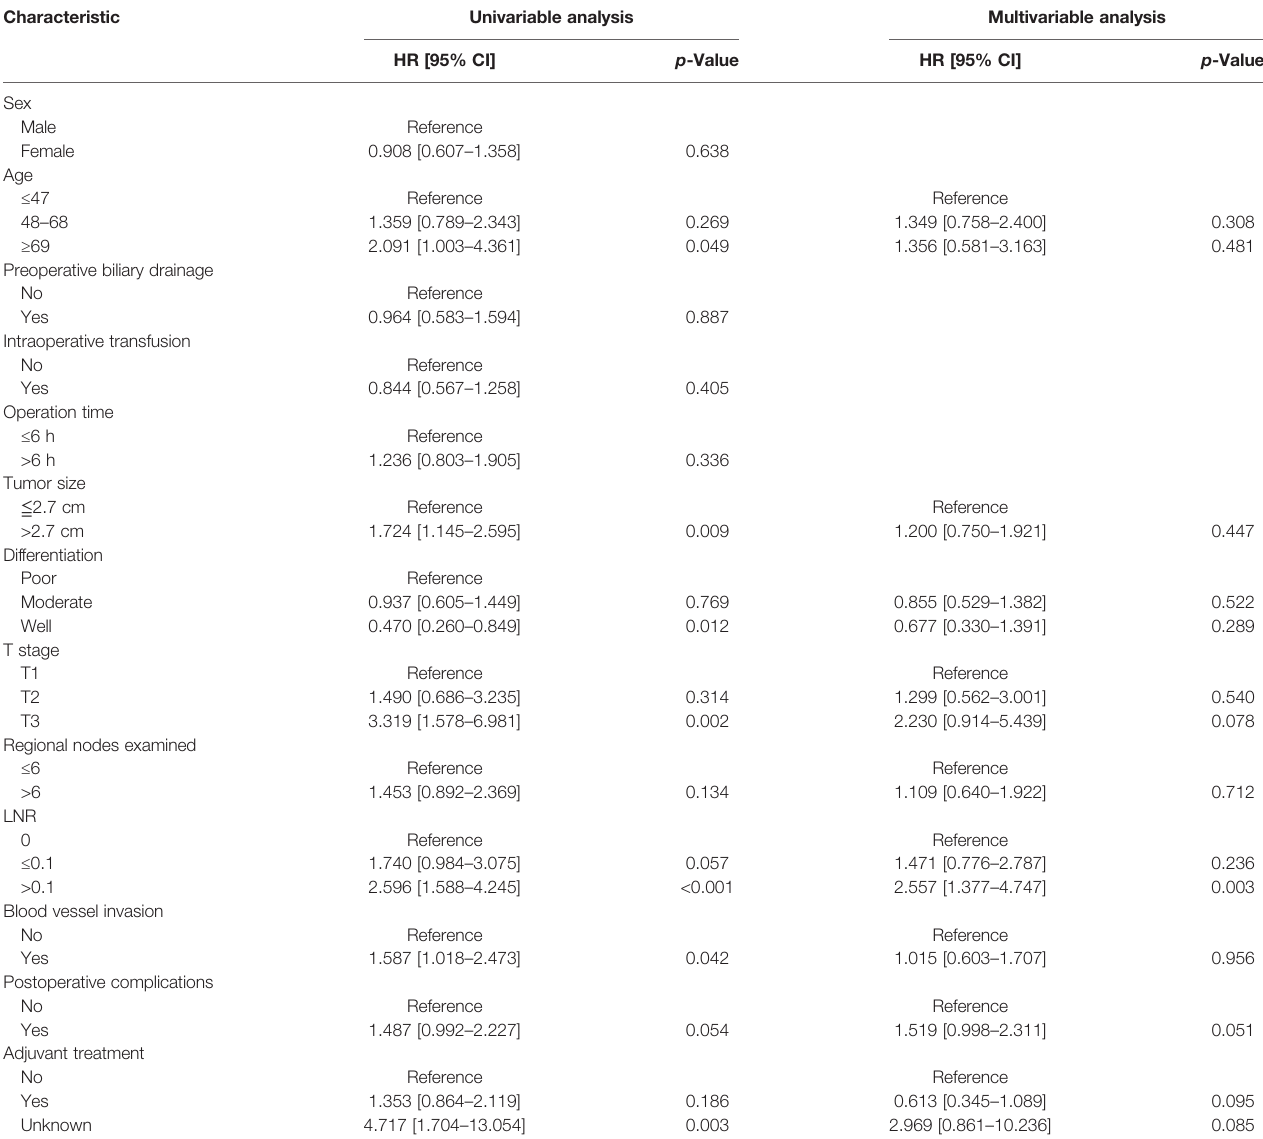
TABLE 2 | Univariate and multivariate Cox regression analyses of OS of the AC patients in the training cohort.